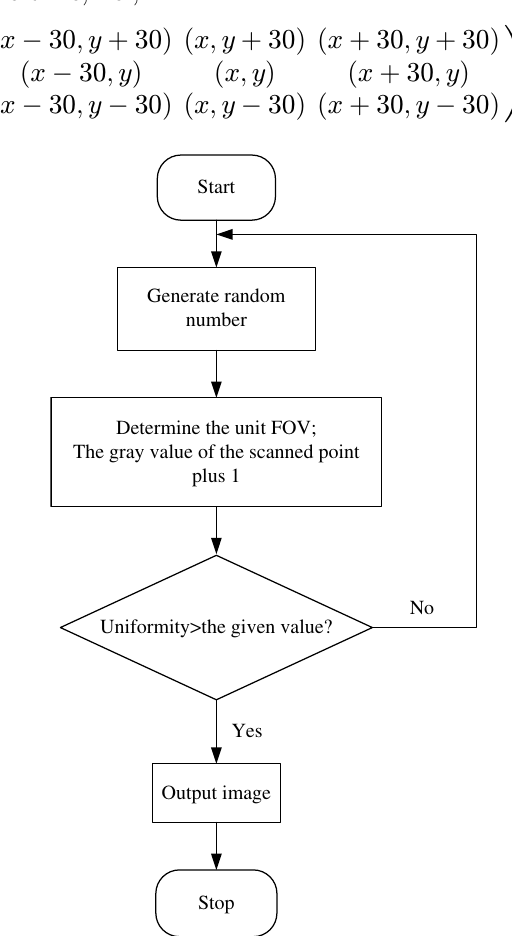
Fig. 4. Flow chart of stochastic scanning